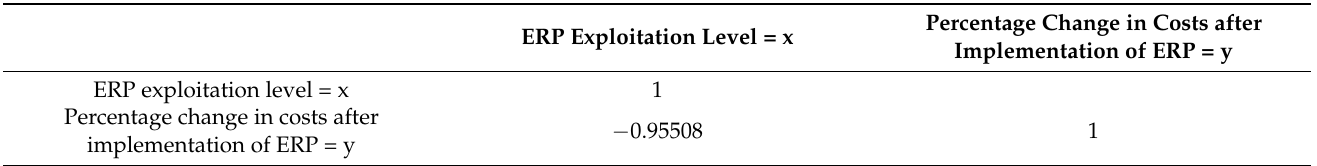
Table 3. Pearson correlation (ERP exploitation level and cost savings).